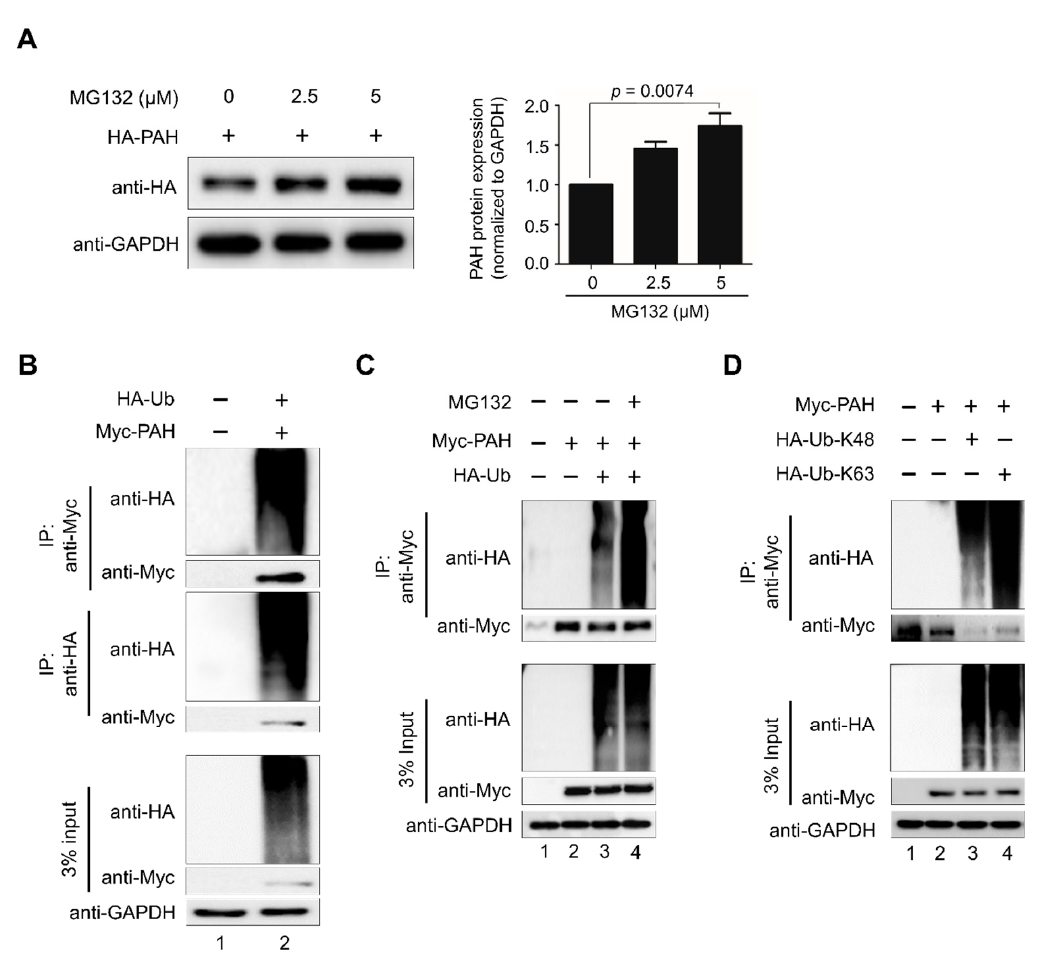
blotting with the indicated antibodies. Band intensity was estimated using ImageJ software, normalized with GAPDH, and represented graphically. The data shown here are the mean ± SD of three